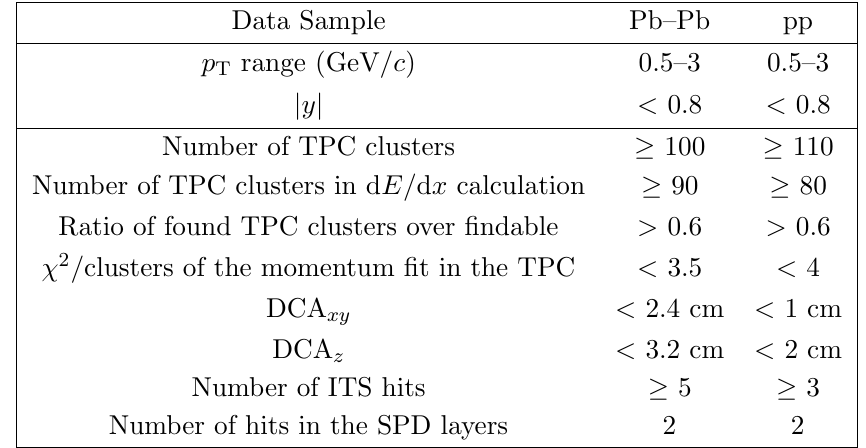
Table 2 . Track selection criteria used in the analyses. DCA is an abbreviation for the distance of closest approach of a track to the primary vertex.